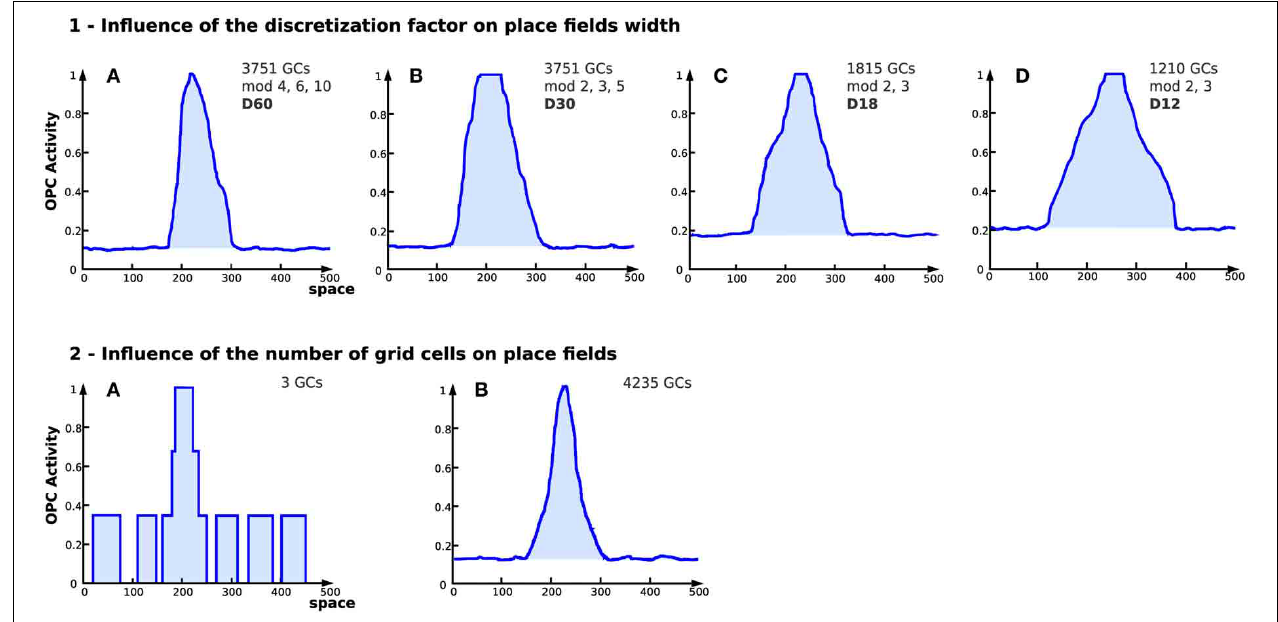
FIGURE 9 | Influence of discretization and number of grid cells on place fields in simulation (Experiment 7). On each figure, the x axis represents space (the distance from the starting point in an abstract unit) while the y axis represents the activity of a place cell (a WTA learns the conjunction of grid cells, see Section 2.4). (1) Influence of the discretization factor on place fields width. Place cell obtained from grid cells depending on different parameters [4 different setups ( GCs ) corresponds to the number of